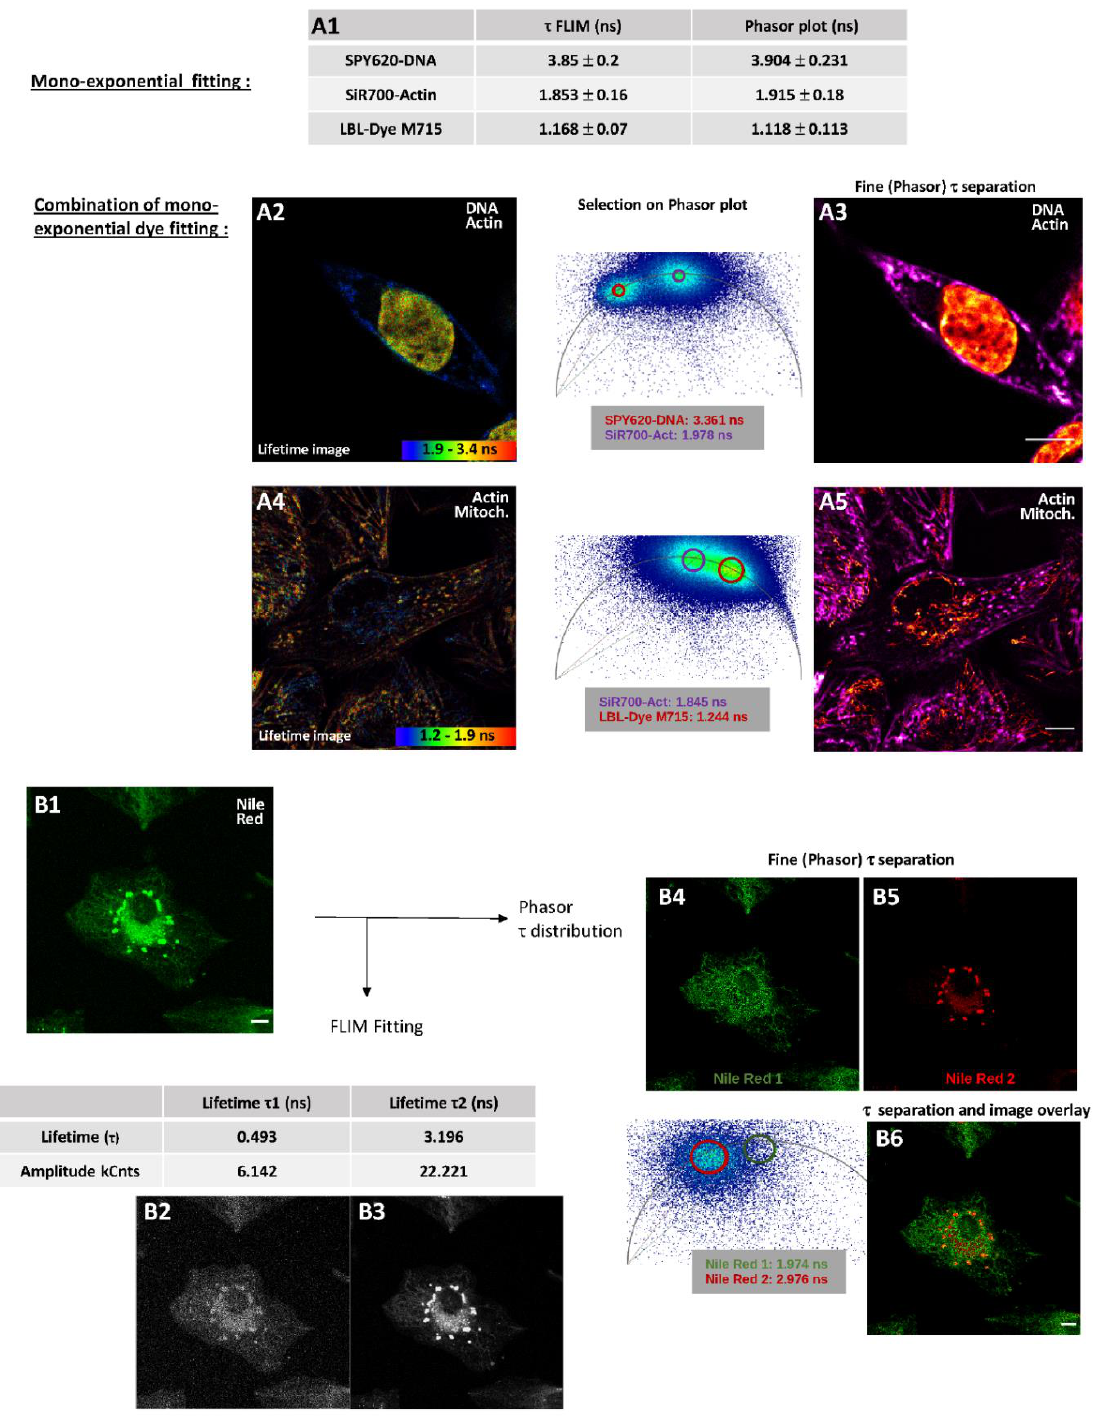
Figure 5. Input of fitting and phasor plot analyses in fluorescence lifetime microscopy (FLIM) of living H28 cells labeled with red/near-infrared dyes. ( A1 ) Determination of fluorescent lifetimes for SPY620-DNA, SiR700-Actin and LBL-Dye M715 by using fitting and phasor plot analyses. FLIM ( A2 ) and fine τ separation ( A3 ) images of SPY620-DNA- and SiR700-Actin-labeled H28 cells (ex 618 nm, 5%; em 623–770 nm, HyD-X). FLIM ( A4 ) and fine τ separation ( A5 ) images of SiR700-Actin and LBL-Dye M715 labeled H28 cells (ex 698 nm, 6%; em 708–774 nm HyD-X). ( B1 ) Confocal imaging (signal intensity) of Nile Red-labeled H28 cells (ex 552 nm, 3%; em 560–650 nm, HyD-X). Separated images through ( B2 , B3 ) fitting analysis or ( B4 , B5 ) fine τ separation (phasor plot) of Nile Red-labeled H28 cells after activation of FALCON module. Overlay of resulting fine τ separation images ( B6 ). Scale bars 10 µ